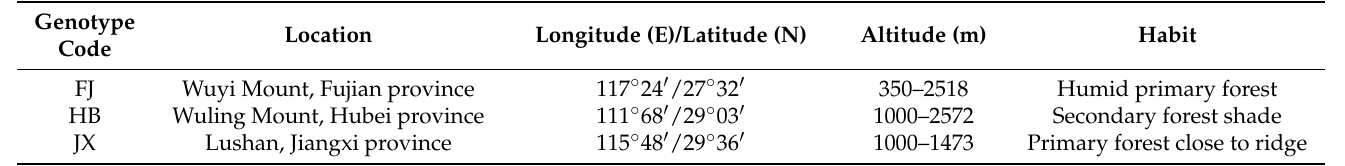
Table 7. Explants of three different genotypic H. serrata used for micropropagation In vitro.